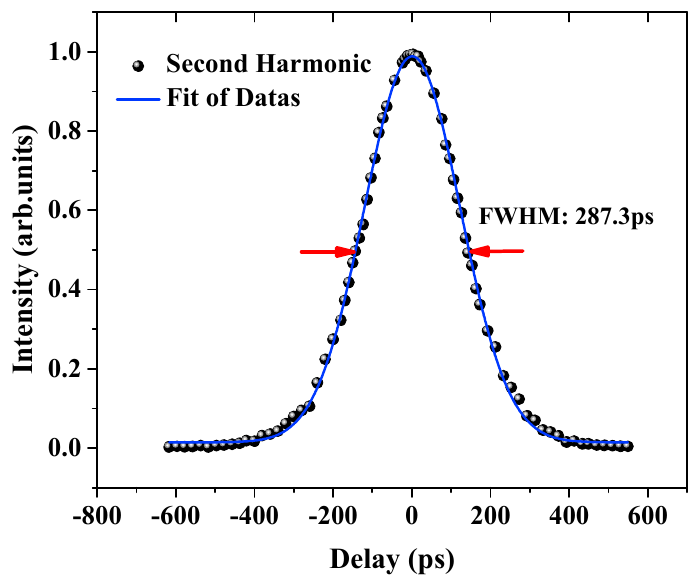
Figure 11. Autocorrelation curve of the QML operation. The output wavelength of the passively Q-switched and mode-locked Er 3+ -doped fiber laser is shown in Figure 12, measured by a Co. EXFO 1500 laser wavemeter (1 pm resolution). The emission spectra is guided by an InGaAs detector with a SRS830 lock-in amplifier for signal extraction. As shown, the center wavelength is 1562.8 nm with a FWHM line-width of about 24 pm, and there are no other emission oscillates with it simultaneously.